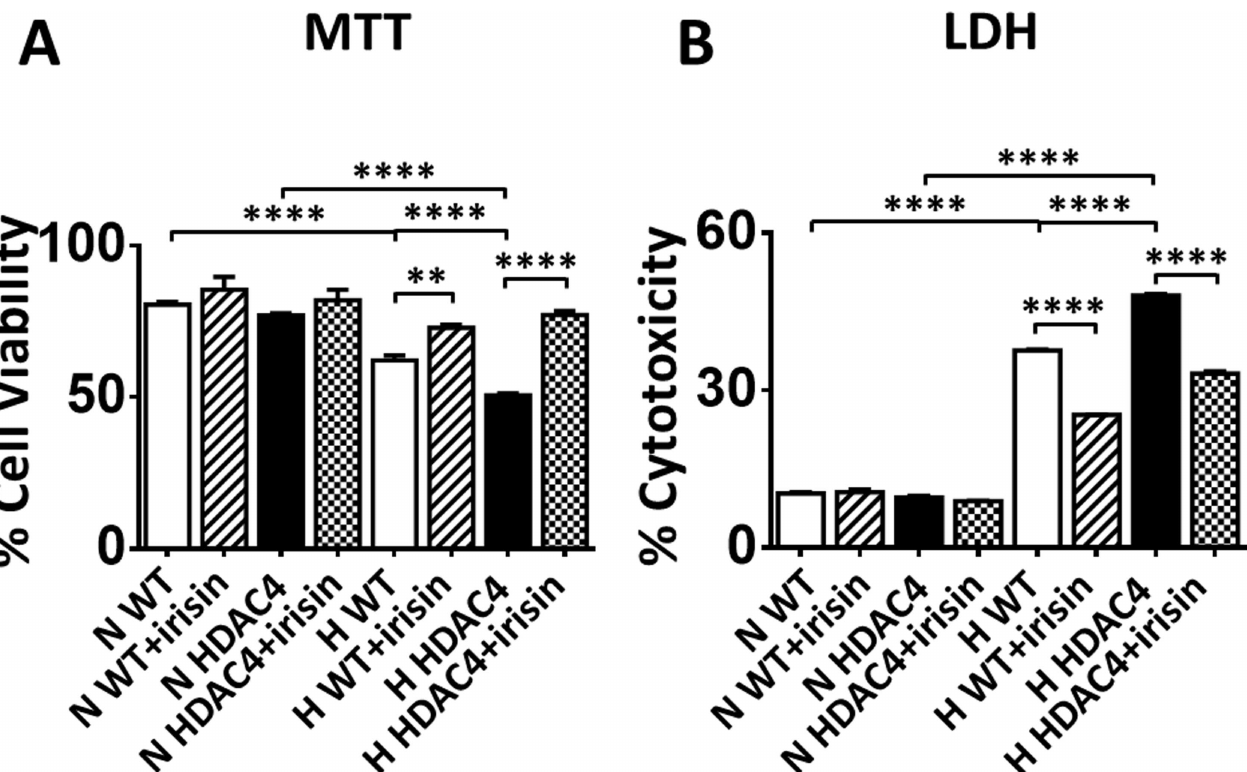
Fig 2. Effects of irisin on cell viability and cytotoxicity. (A) Irisin increasedcell survival and rescuedHDAC4-induced injury in cardiomyoblasts exposedto hypoxia/reoxygenation. (B) Irisin attenuated cytotoxicity and rescuedthe HDAC4-induced cell damagein hypoxia/reoxygenation. Values represent means ± SEM(n = 3/group). ** P < 0.01, **** P < 0.0001.